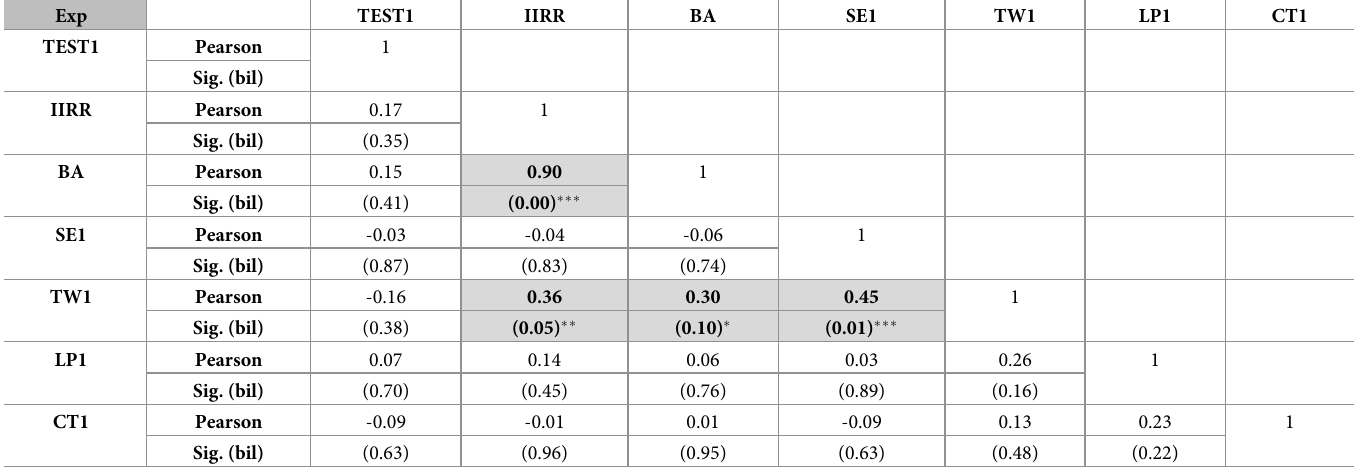
Table 4. Pearson correlations: Experimental group before the experiment.